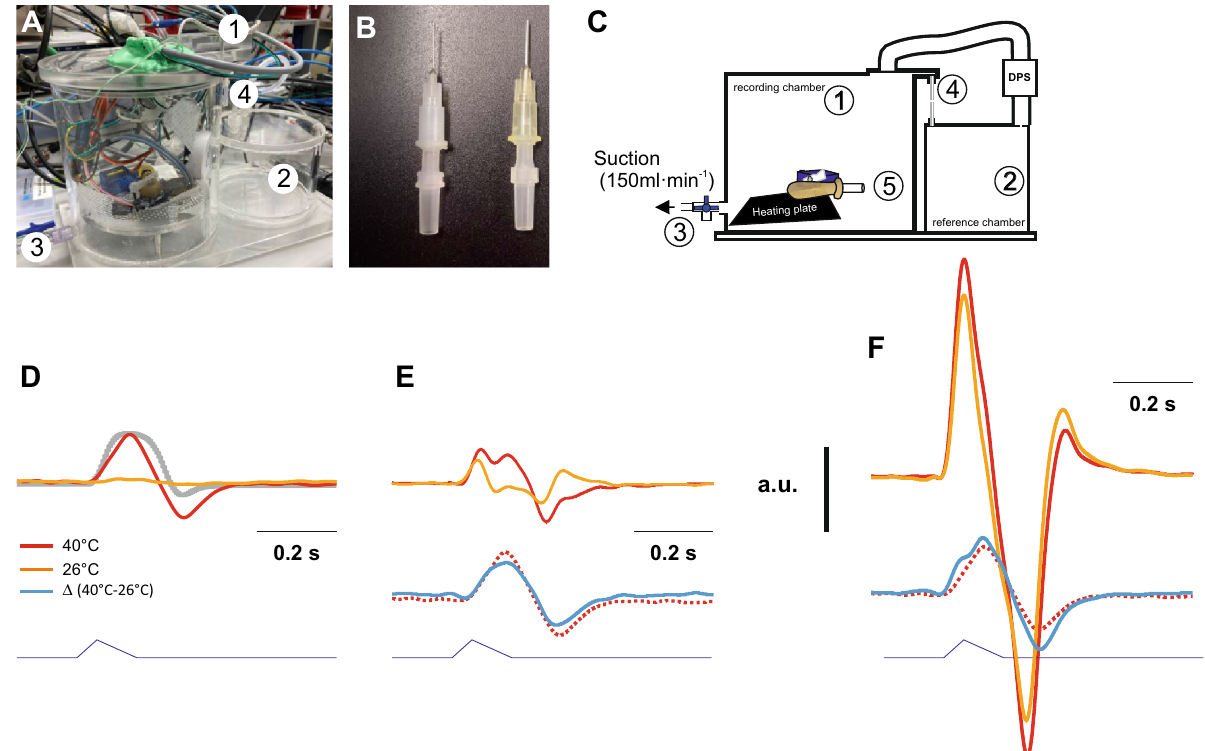
Figure 2. Experimental testing of the ALM placed inside the plethysmography chamber. ( A ) Photograph of the lung dummy in the FWBP plethysmography chamber. Cables passing through the lid of the chamber, secured and sealed by polymer clay (1). ( B ) Different cut luer-lock cannulas were used to adjust the resistance of the ALM. ( C ) Schematic drawing of the chamber design. The flow through mode was used by applying constant suction of 150 ml/min to the outlet port (3) with a 3-way-valve. At the inlet port (4), the flow was limited by a defined resistance, a silicon tube (τ 58 ms). Pressure changes were recorded with a differential pressure sensor (DPS) between the recoding chamber and a reference chamber (2). ( D – F ) Analysis of the effect of the different degrees of airway resistance. To mimic low airway resistance ( D ) no cannula was attached to “tracheal” opening of the dummy lung (5). To apply additional resistance either a cut 20G (yellow, E ) or a cut 27G (white, F ) cannula was attached to the luer adapter. ( D ) Chamber pressure (non-calibrated) in the no-resistance situation. The lower trace represents the analog control signal for the micro servo motor (T I 50 ms, T E 100 ms). Traces in red are from recordings with the heating plate turned on (40 °C; see Fig. 1) and the yellow trace with the heating plate off (26 °C). The chamber pressure follows the lever of the servo motor with a short delay (see also Fig. 4). Note that with no temperature added to the ALM, almost no pressure change is measured (yellow trace). ( E , F ) Effects of addition of airway resistance. ( E ) With the first resistance (20G) the pressure in the chamber changes already in the unheated dummy lung (26 °C), with an obvious difference between the signal at 40 °C (red) and 26 °C (yellow). Subtraction (blue trace) of the 26 °C signal from the 40 °C signal reveals the pressure change that is based on warming of the air during the breath. Interestingly, it almost equals the change when no resistance was used (dotted trace). ( F ) Using a larger resistance (27G), the pressure changes are increased, moreover the difference between the signal at 40 °C and 26 °C is not easy to appreciate anymore. However, subtraction (blue trace) of the 26 °C signal from the 40 °C signal reveals that the flow that is based on warming is still very similar. The gray trace ( D ) resembles the pressure curve shown in Fig.